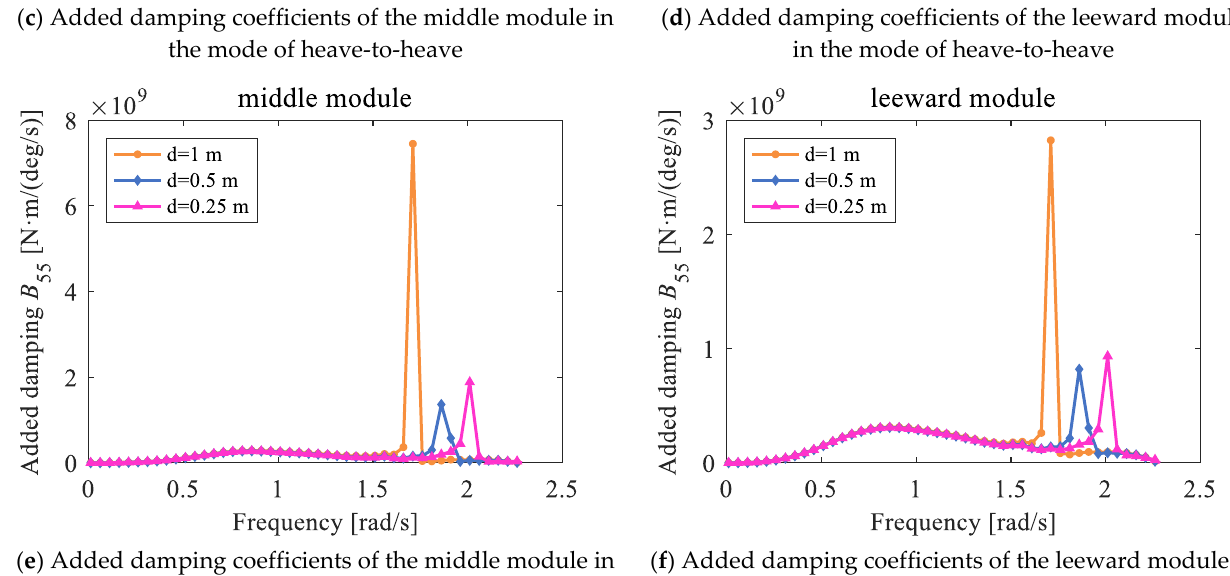
nomenon at the specific frequency calculated by potential theory is extremely significant